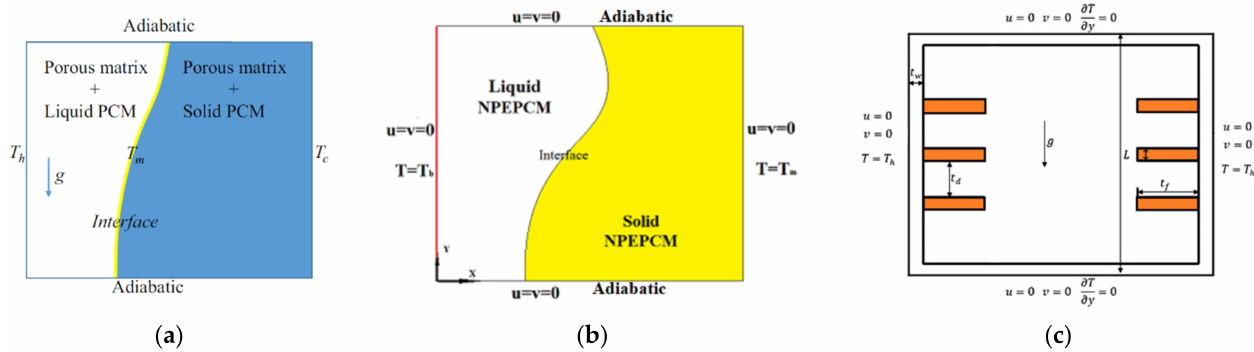
Figure 1. Schematic of the domains of enhanced PCM problems: ( a ) implementing porous media [7], ( b ) using nanoparticle-enhanced PCMs [8], and ( c ) using finned cavities